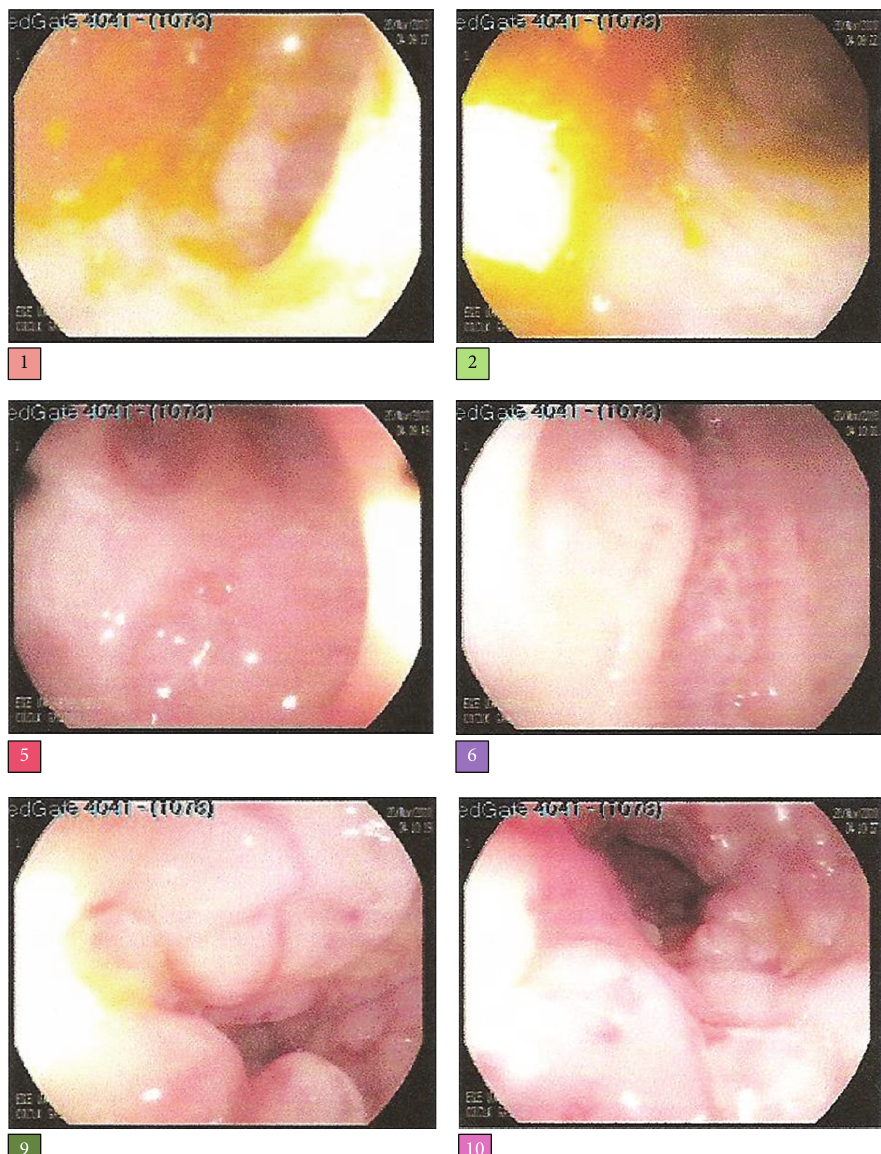
Figure 2: Colonoscopy images of the patient showing granularity of the right colon, exudative mucosal ulceration, pseudopolyps, laseration, and loss of haustration of the left colon, compatible with